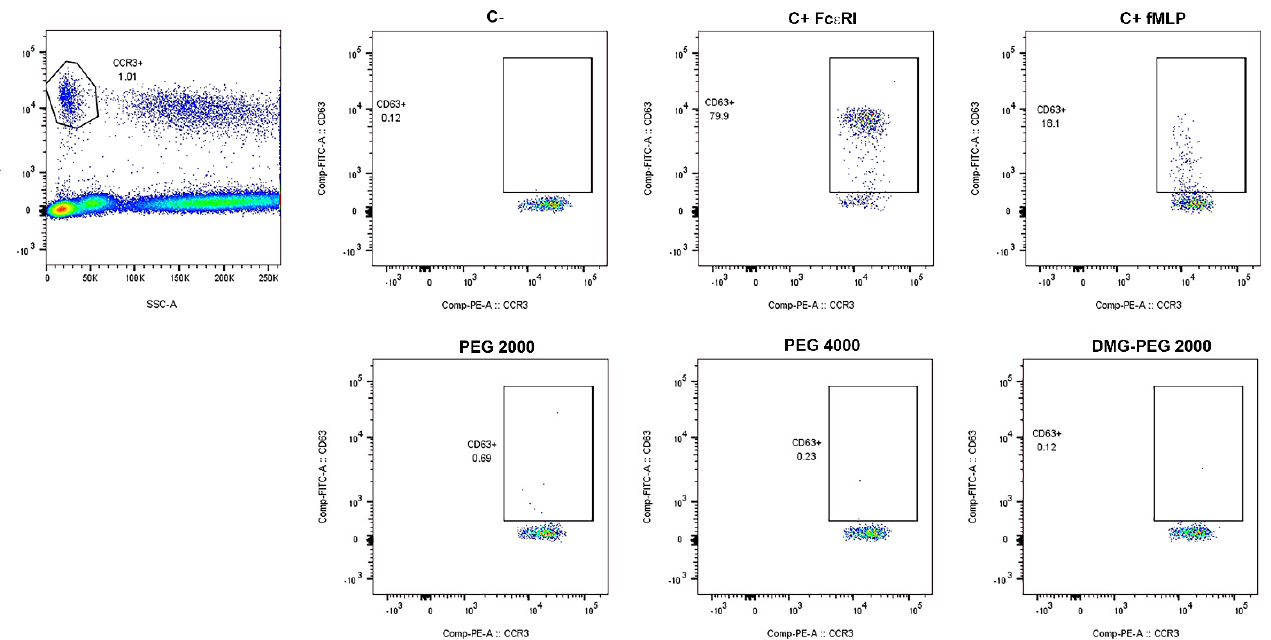
Figure 1. Gating strategy. SSClow/CCR3+ events were firstly selected on an SSC-A/CCR3-PE dot-plot, and then CD63-positive basophils were identified on a CCR3-PE/CD63-FITC dot-plot for the negative control (C − ), positive controls (C+ Fc ε RI and C+ fMLP) and allergens (PEG 2000, PEG 4000 and DMG-PEG 2000). The gating strategy is representative of all analyzed samples. Int. J. Mol. Sci. 2022 , 23 , x FOR PEER REVIEW